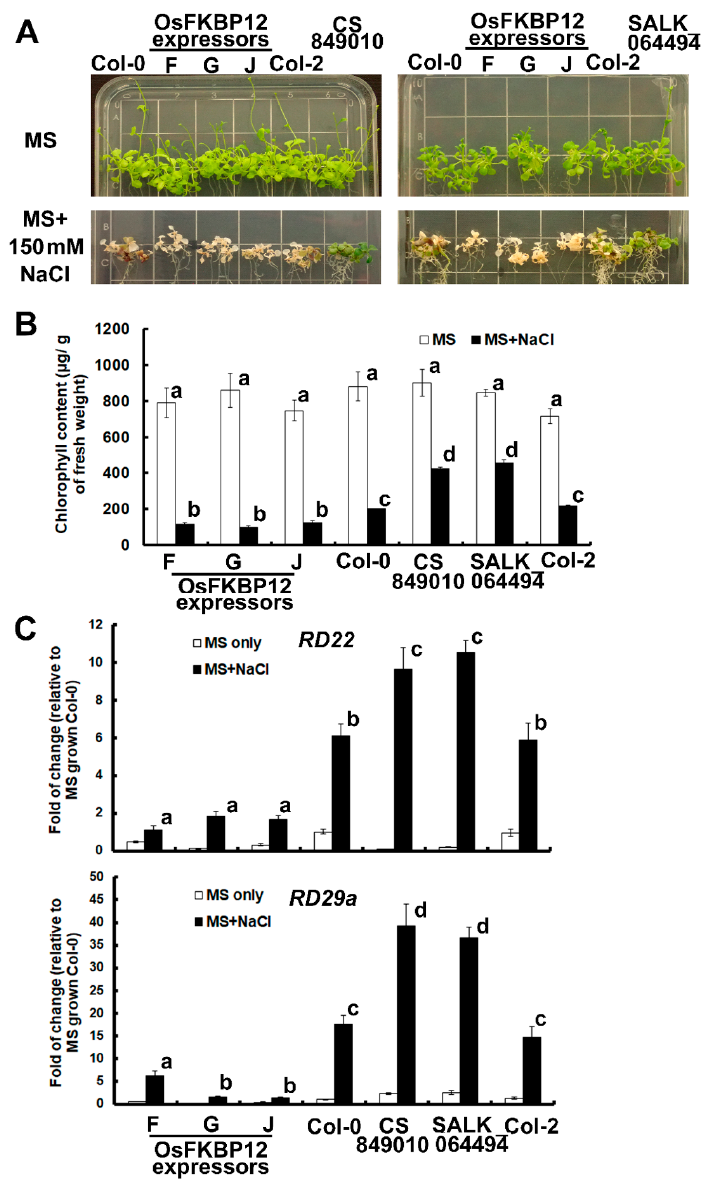
Figure 4. Salt treatment of OsFKBP12- transgenic A. thaliana . Ten-day-old seedlings grown on MS agar plates were transferred onto MS plates supplemented with 150 mM NaCl (salt treatment) or MS-only plates (mock treatment). Phenotypes of salt stress were recorded after 10 days of treatment. ( A ) Leaf chlorosis was severe in the three OsFKBP12-expressors, and AtFKBP12- knockout mutant lines (CS849010 and SALK_064494) exhibited very minor leaf chlorosis, while wild-type lines (Col-0 and Col-2) were somewhere in between in terms of stress phenotype. ( B ) Chlorophyll contents were determined to quantify the degree of leaf chlorosis. ( C ) The expressions of salt-inducible genes ( RD22 and RD29a ) were obtained from samples harvested after 1 day of salt treatment. Relative gene expressions were calculated using the 2 − ∆∆ CT method, with UBQ10 as the normalizing gene [28,29]. The expression levels of RD22 and RD29a in Col-0 under mock treatment were set to 1 for reference. Statistical significance was analyzed using one-way analysis of variance combined with the Games–Howell post hoc test. Error bars represent standard errors with at least three biological replicates. Different lowercase letters above the bars represent statistically distinct groups at p < 0.05. Two biological repeat experiments were conducted with similar